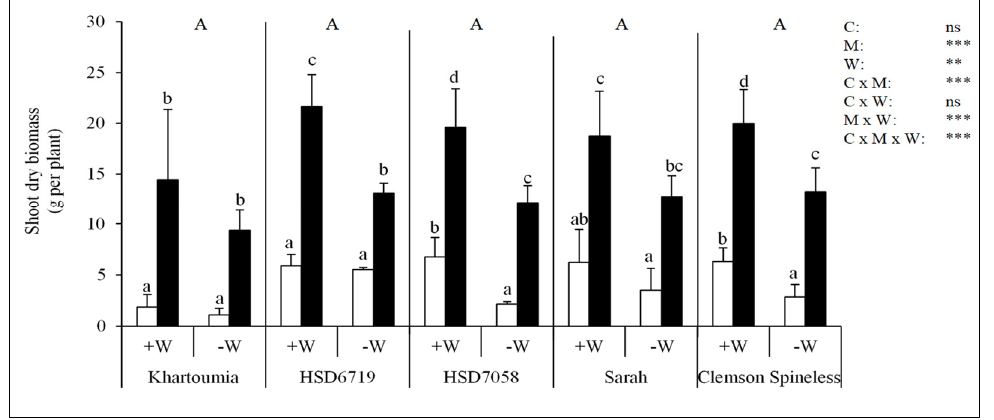
Figure 4. Shoot dry biomass for the five okra cultivars. Plants were non-inoculated (white bars) or inoculated with R. irregulare (black bars). Asterisks indicate significant differences in cultivar (C), AM inoculation (M) and substrate water content (W) and their interactions (Kruskal-Wallis test, n = 4, p < 0.05 (*), p < 0.01 (**), p < 0.001 (***) and p > 0.05 (ns)). Shown are mean values ± standard deviation. Within each cultivar mean values followed by the same small letter are not significantly different (Tukey’s test, n = 4, p < 0.05). Cultivars followed by the same capital letter are not significantly different (Tukey’s test, n = 4, p <